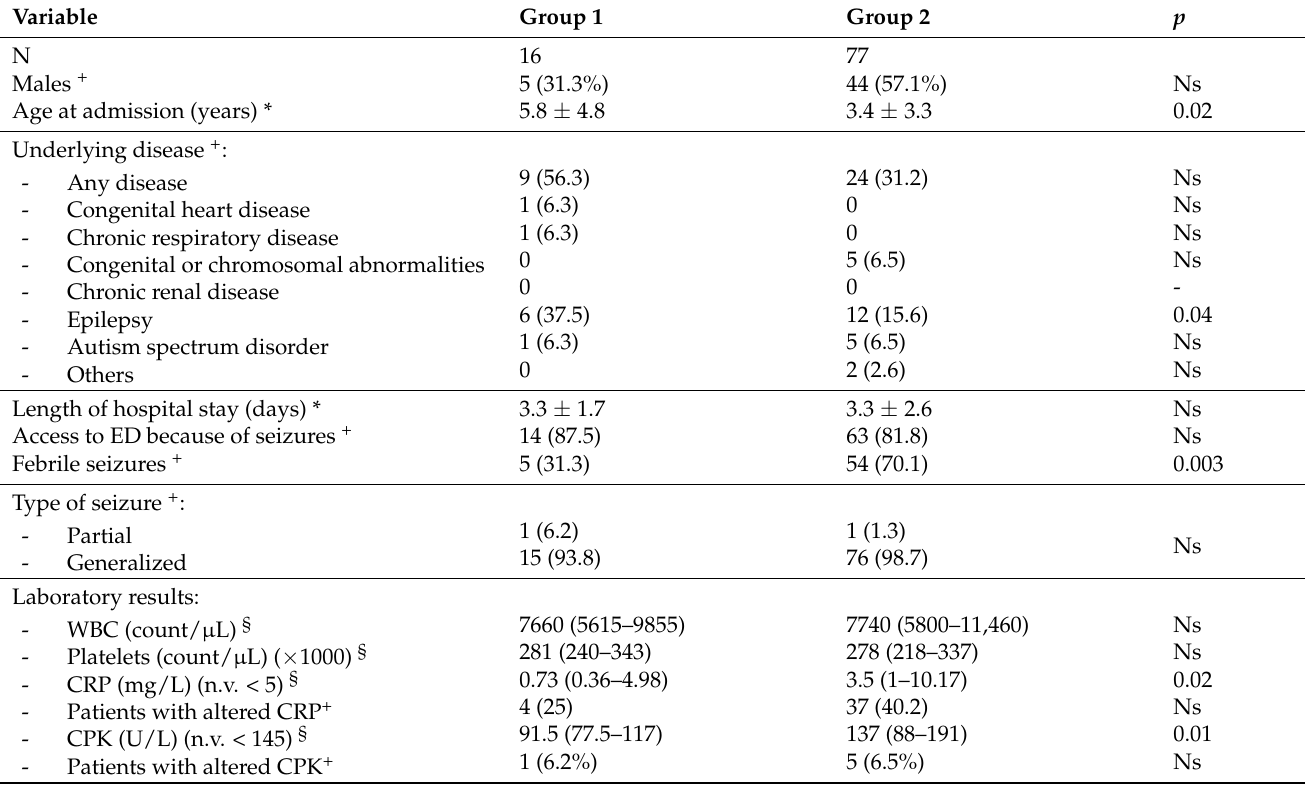
Table 2. Comparison between patients with seizures observed before (Group 1) and after (Group 2) January